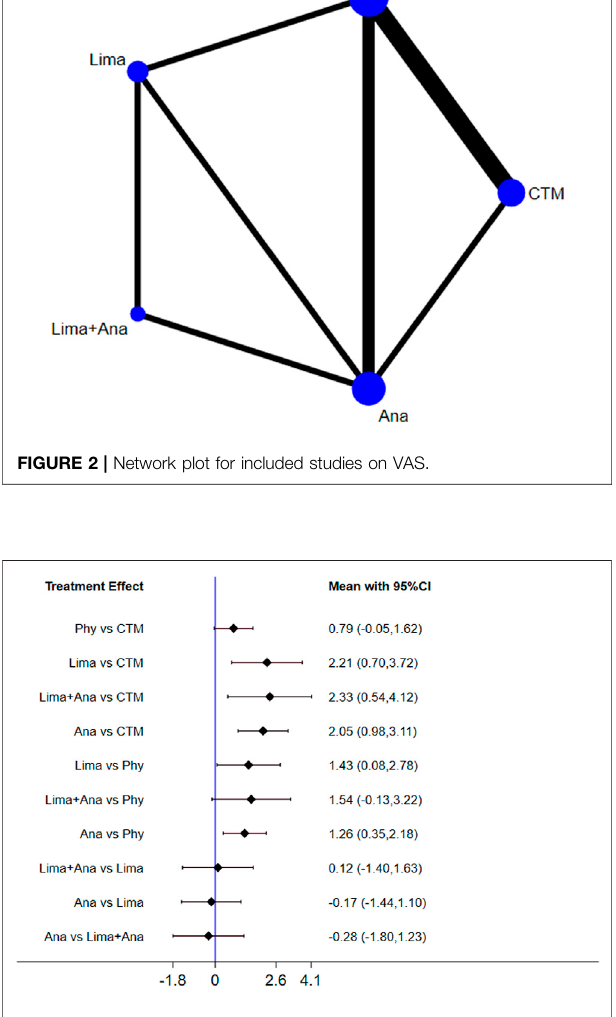
FIGURE 3 | Mean difference for VAS between treatments.